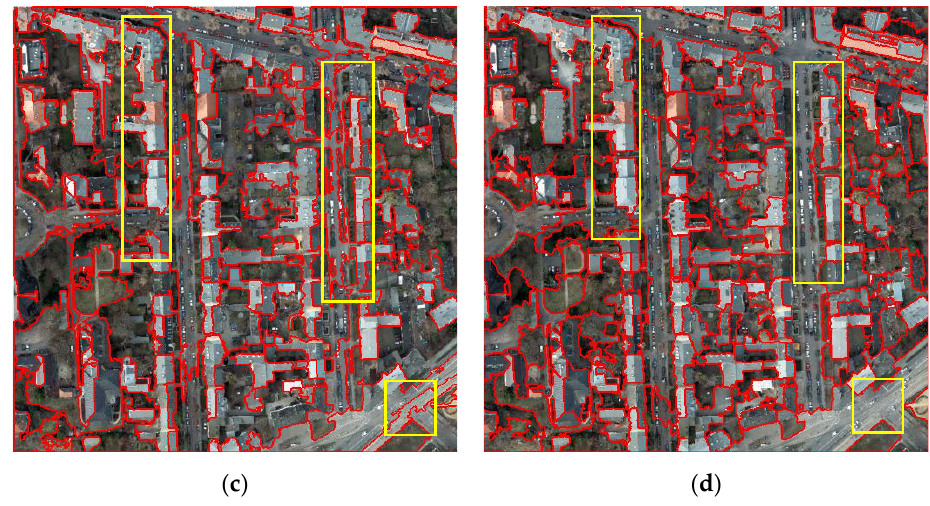
Figure 13. Segmentation results produced by different methods for the Potsdam aerial image (T5): ( a ) WTS; ( b ) MS; ( c ) MRS; ( d ) MMHS.